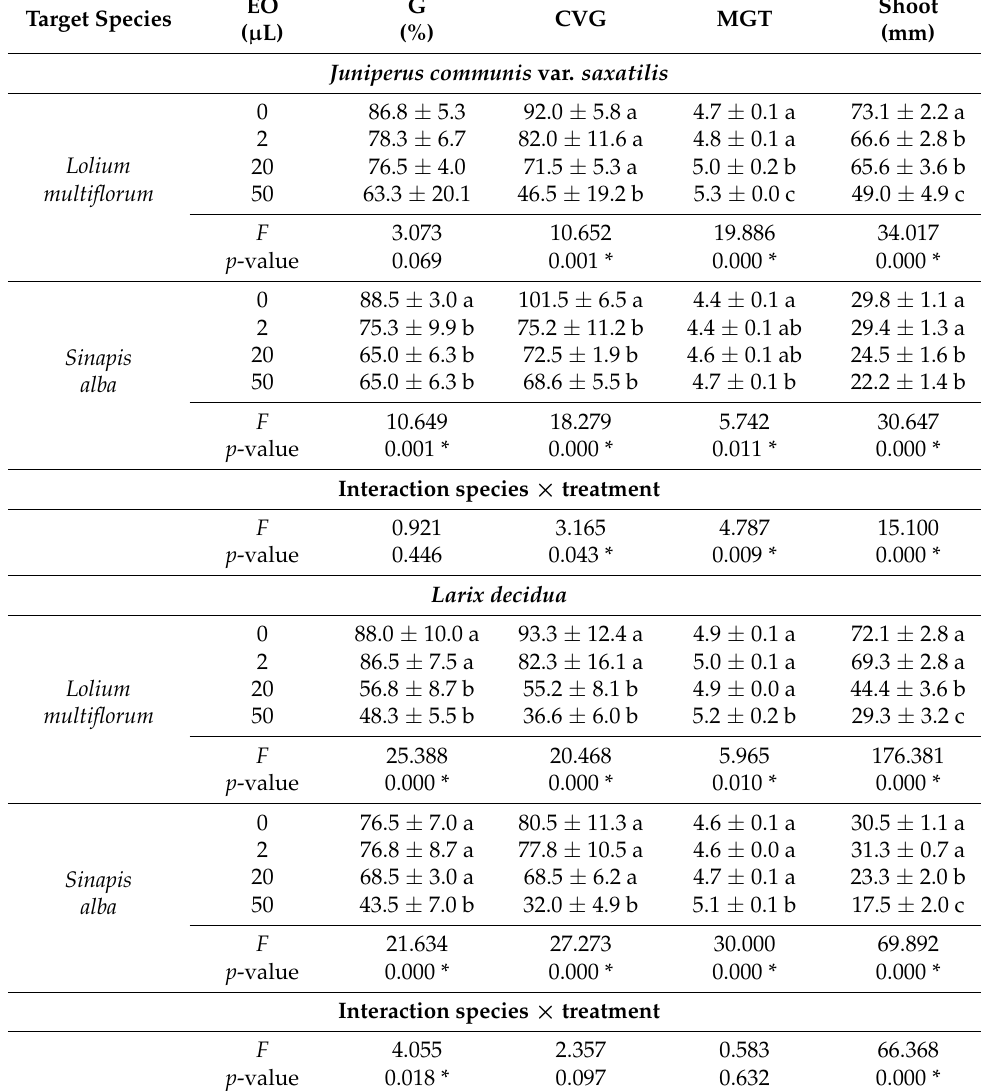
Table 7. Germination and growth values of two target species ( Lolium multiflorum and Sinapis alba ) under the phytotoxic effects of different doses of Juniperus communis var. saxatilis and Larix decidua EOs using soil as a